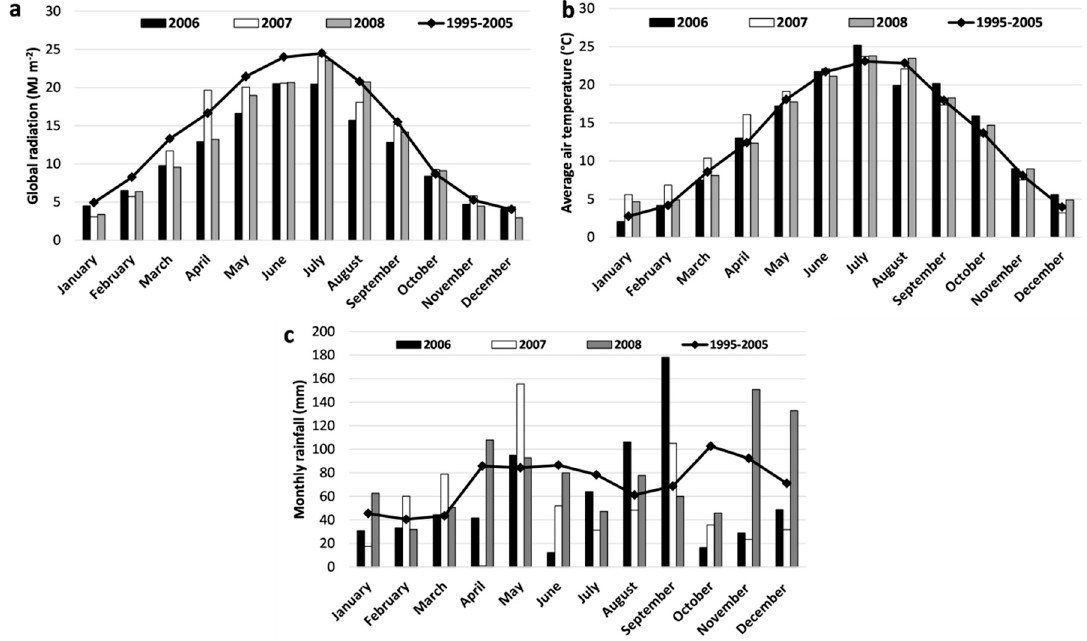
Figure 1. Average global radiation (MJ m − 2 ) ( a ), air temperature ( ◦ C), ( b ) and cumulated monthly rainfall (mm) ( c ) recorded during the experimental period of plants harvesting and measurements.